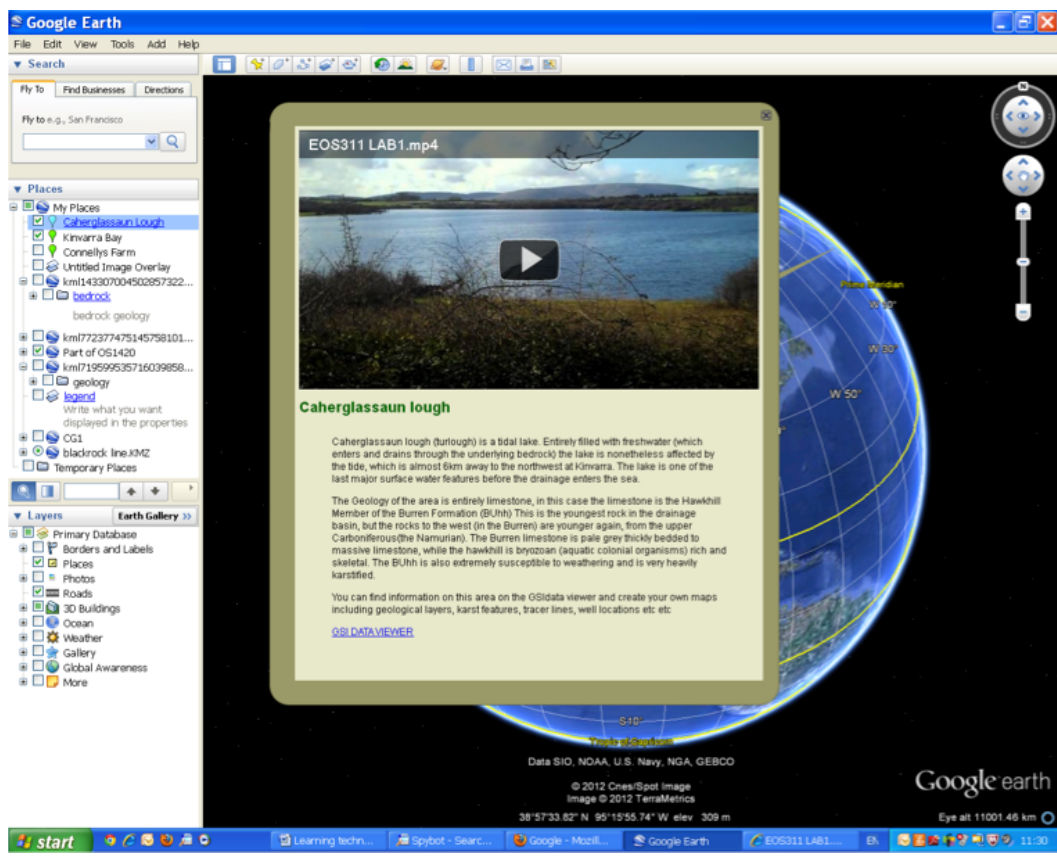
Figure 1: Google Earth. Placemark balloon with field trip video